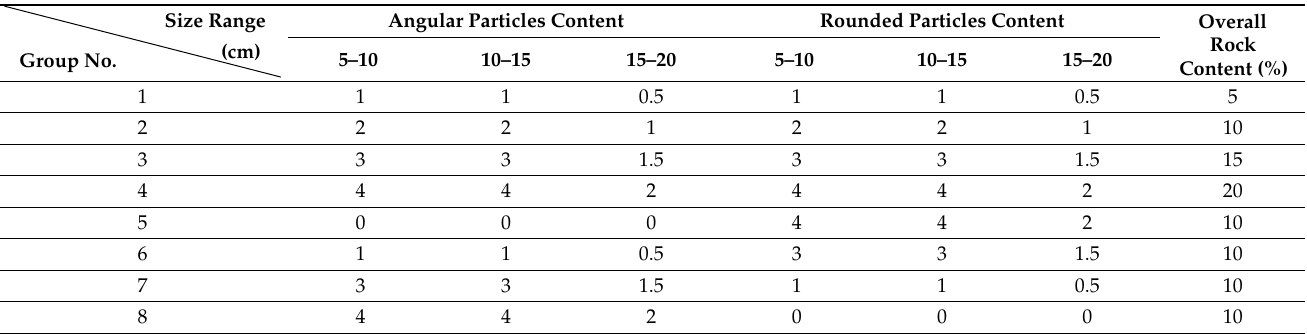
Table 1. Study matrix of generating different mesostructures with varied rock contents and parti- cle shapes.